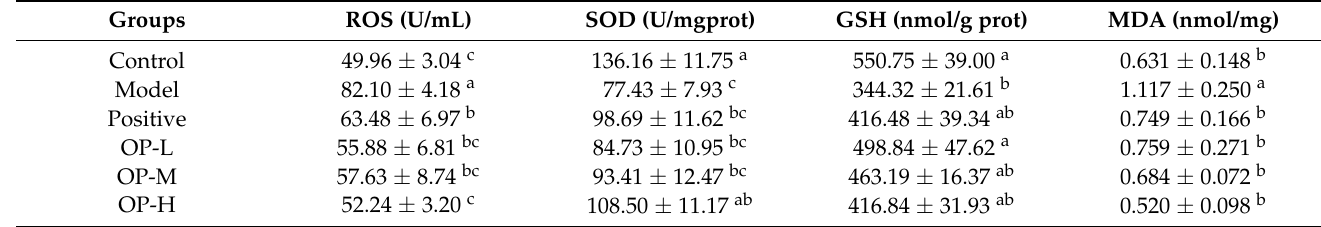
Table 1. Effect of OP on oxidative stress factors in tissues of the ALD